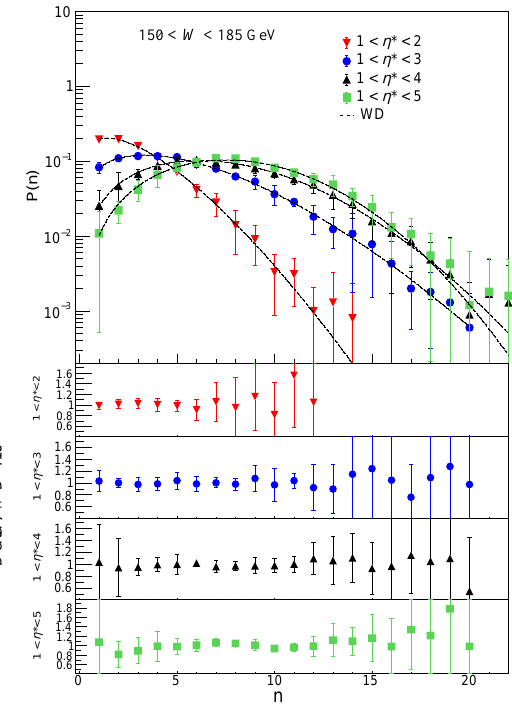
Figure 8. Multiplicity distributions fits with the Weibull probability function in 150 < W < 185 GeV in different η ∗ ranges of the H1 data [33]. The lower panel shows the data/WD-fit ratio plots for different η ∗